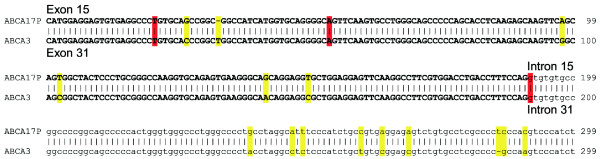
Discrete regions of the ABCA17P gene show near perfect sequence identity with corresponding segments of the ABCA3 gene. This is exemplified for ABCA17P exon 15 (+ partial intron 15) and ABCA3 exon 31 (+ partial intron 31), respectively. Bold capital letters represent exon and small letters intron sequences. Red shaded nucleotides indicate known mutation sites in the ABCA3 gene in individuals with neonatal surfactant deficiency. Yellow shaded letters denote non-identical nucleotides.